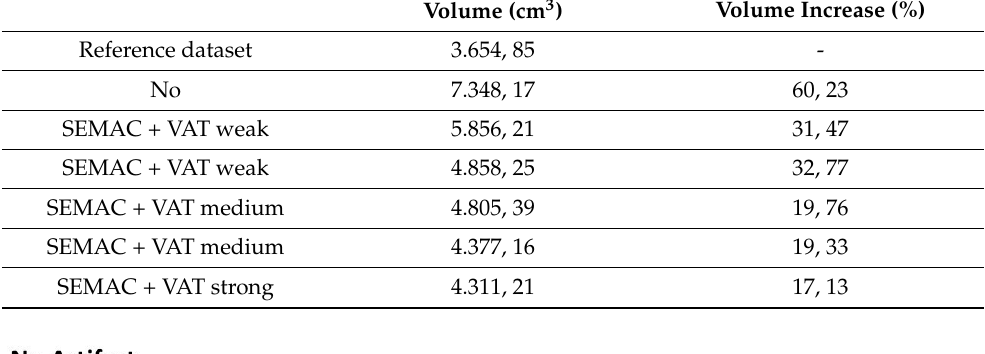
Table 3. Mandible volume (cm 3 ) and volume increase (%) in comparison to the reference dataset.